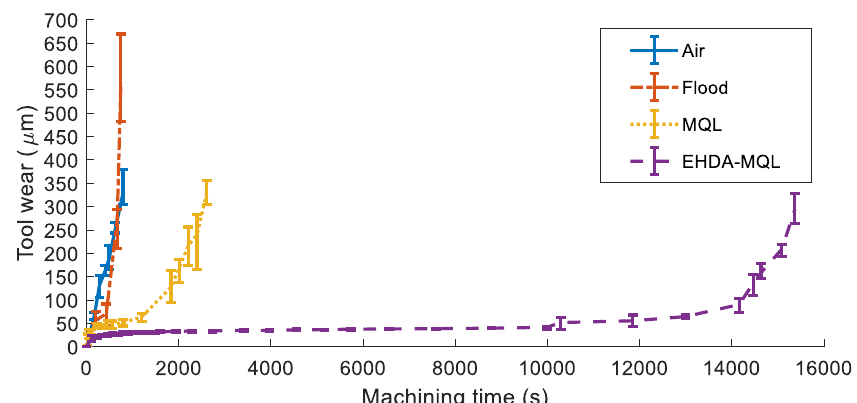
Figure 5. Tool-wear growth against machining time for various cooling-lubrication systems.